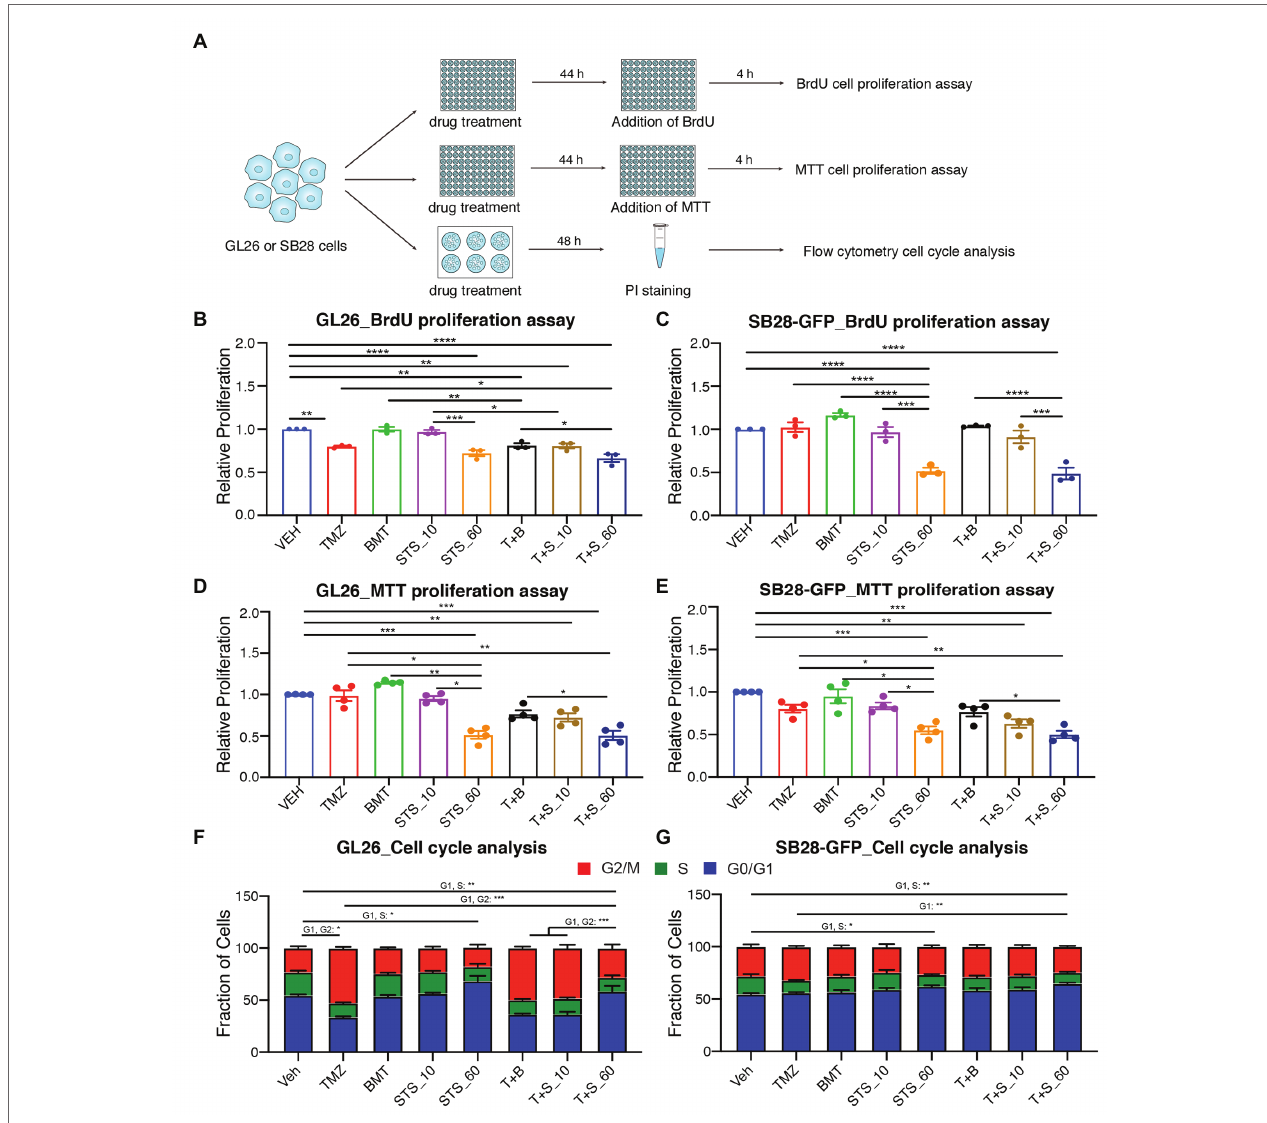
FIGURE 3 | STS66 reduces glioma proliferation and cell cycle in combination of chemoreagent temozolomide. (A) Experimental protocol. GL26 or SB28-GFP cells were exposed to DMSO (Veh), TMZ (100 μ M), BMT (10 μ M), STS66 (10 and 60 μ M), T + B, or T + S combined for 48 h and proliferation was determined by BrdU incorporation assay and MTT assay. Cell cycle distribution was analyzed by flow cytometry. (B,C) Relative cell proliferation determined by BrdU incorporation assay. Data are means ± SEM ( n = 3), * p < 0.05, ** p < 0.01, *** p < 0.001, **** p < 0.0001. (D,E) Relative cell proliferation determined by MTT assay. Data are means ± SEM ( n = 4), * p < 0.05, ** p < 0.01, *** p < 0.001. (F,G) Cell cycle distribution was analyzed by flow cytometry after DNA staining with propidium iodide (PI). Data are means ± SEM ( n = 4), * p < 0.05, ** p < 0.01, *** p <